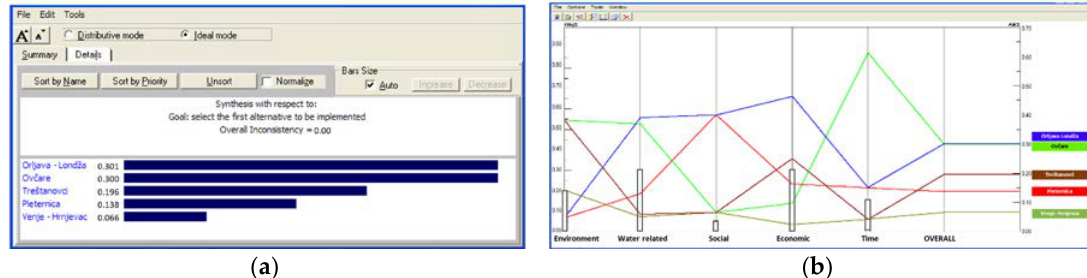
Figure 4. AHP (Analytic Hierarchy Process) results for direct assessment of each alternative by each criterion, and each criterion with regard to the goal for Scenario 1: ( a ) the final ranking, and ( b ) graphical presentation of all alternatives’ assessment by each group of criteria.